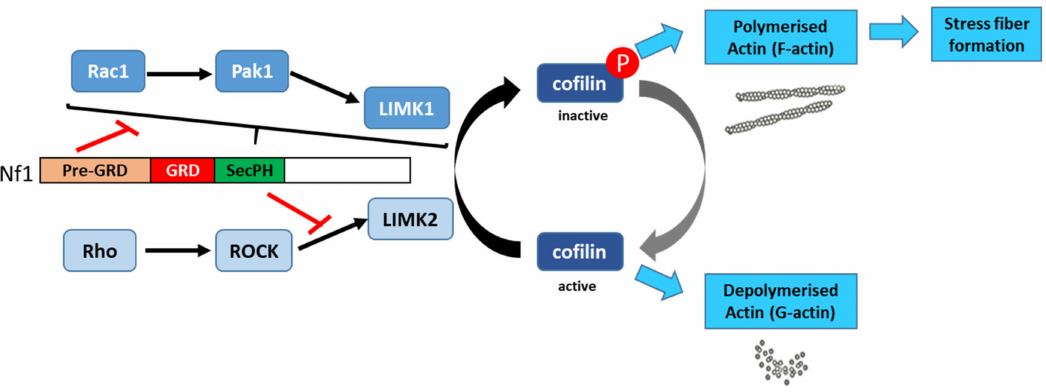
Figure 13. Schematic representation of the mechanisms for neurofibromin-mediated regulation of the actin cytoskeleton